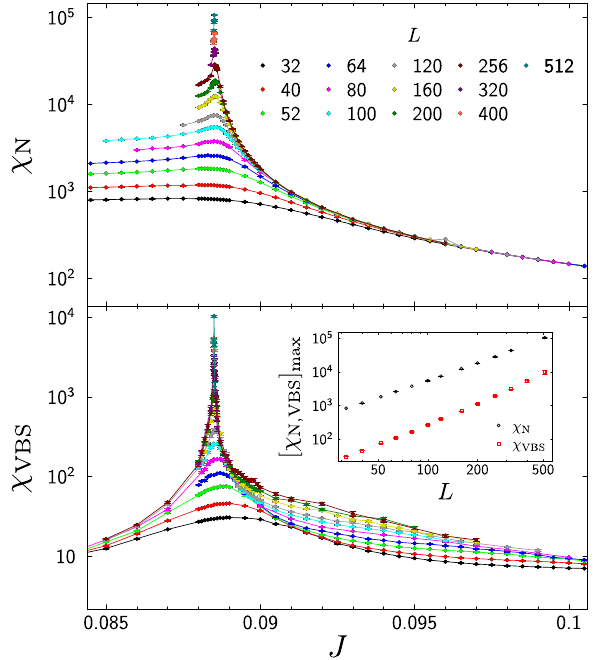
FIG. 10. Susceptibilities for Néel and VBS order parameters. The inset shows peak heights as a function of L